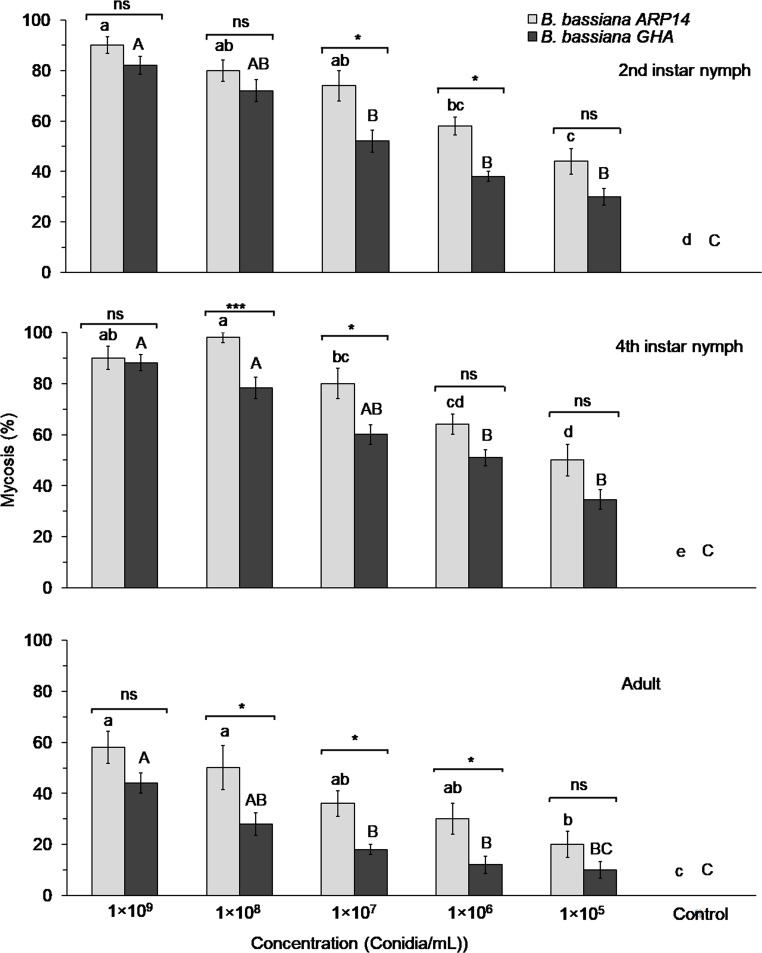
Mycosis rate of Beauveria bassiana ARP14 and GHA strains on 2nd instar nymph, 4th instar nymph and adult stage of Riptortus pedestris exposed in a glass-vial assay for 12 h.Mean mycosis rates followed same letter are not significantly different among the different concentrations of Beauveria bassiana ARP14 (small letters) or GHA (capital letters) (χ2, P > 0.05). Significance of differences between mycosis rates within conidial concentrations, between the ARP14 and GHA strains are denoted as follows: * 0.01<P ≤ 0.05, ** 0.001<P ≤ 0.01, ***P ≤ 0.001 and ns indicates non-significance.